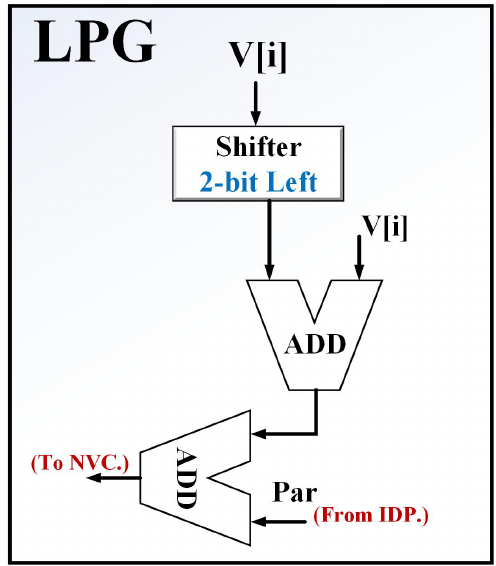
Figure 9. Linear part of the proposed